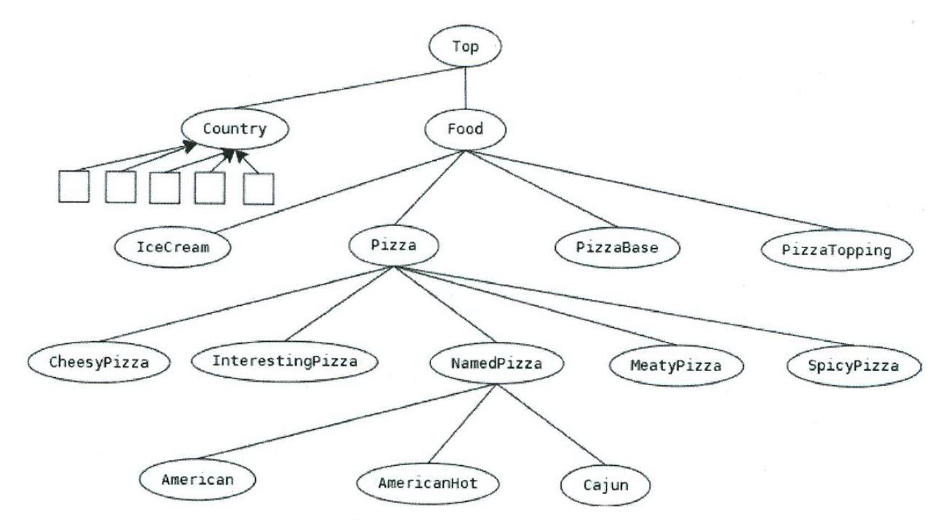
Figure 3. Fragment of the pizza ontology [43].